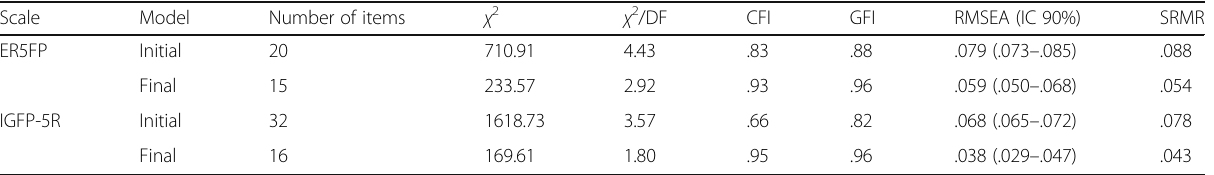
Table 2 Fit indices of the initial and final measurement models of the scales Scale Model Number of items χ 2 χ 2 /DF CFI GFI